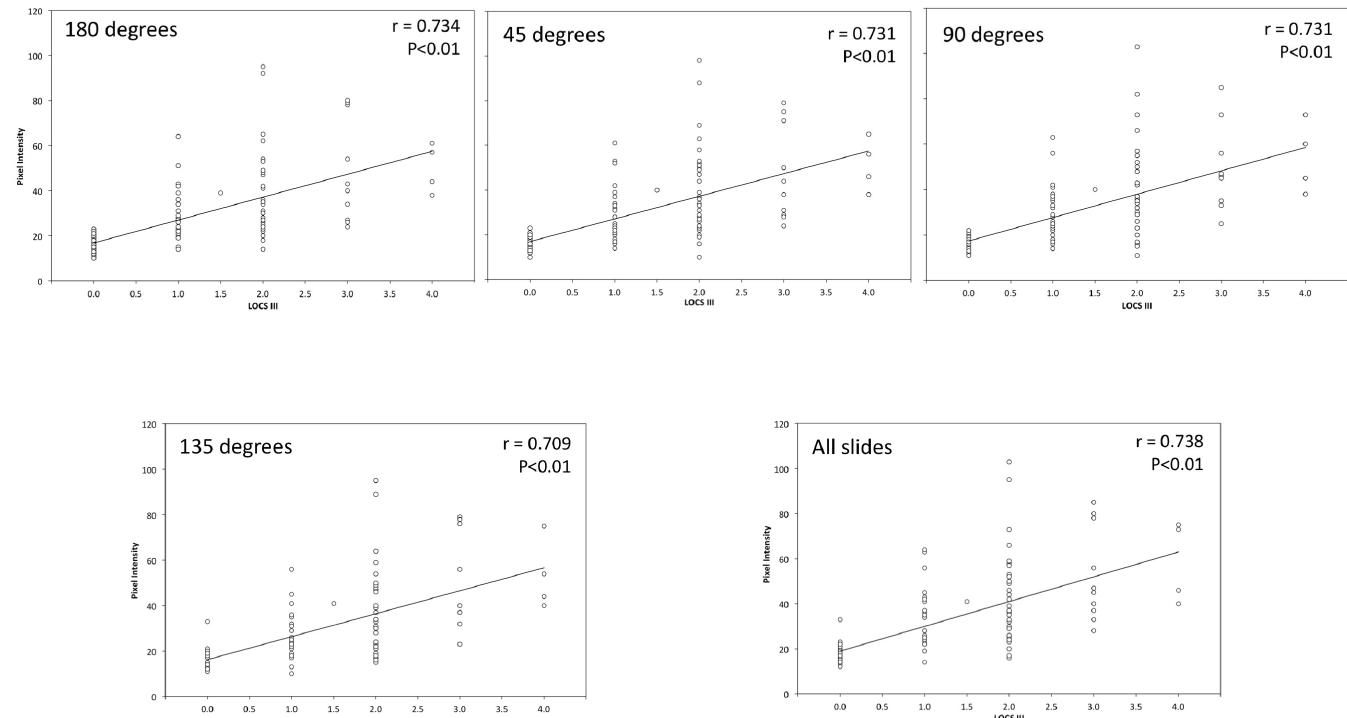
Fig 3. Scatter Plot Representing the Relationship between the Maximum Nuclear Intensity and LOCS III Grade for each Meridian. Top left panel represents the 180 degrees meridian; top centre panel does the 45 degrees meridian; top right panel represents the 90 degrees meridian; bottom left panel does the 135 degrees meridian; and the bottom right panel does the average of the four meridians.